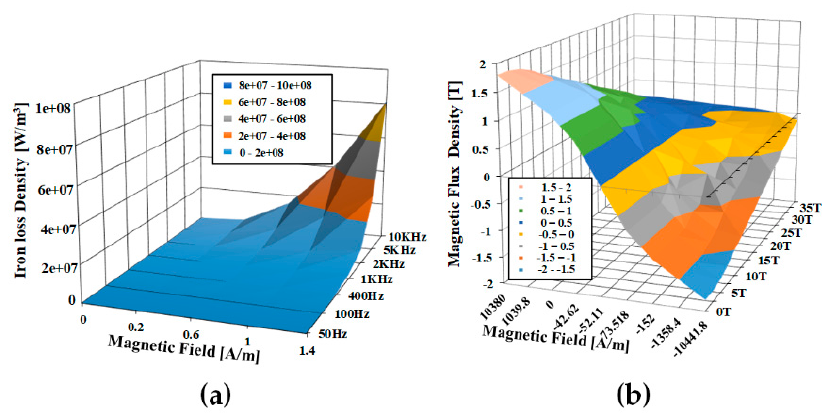
Figure 6. ( a ) End teeth flux density with 12 and 24 A peak phase current input conditions in the time frame. V shape inner permanent magnet rotor surface flux density. ( b ) Comparison of B-H Loops of end teeth and rotor surface.